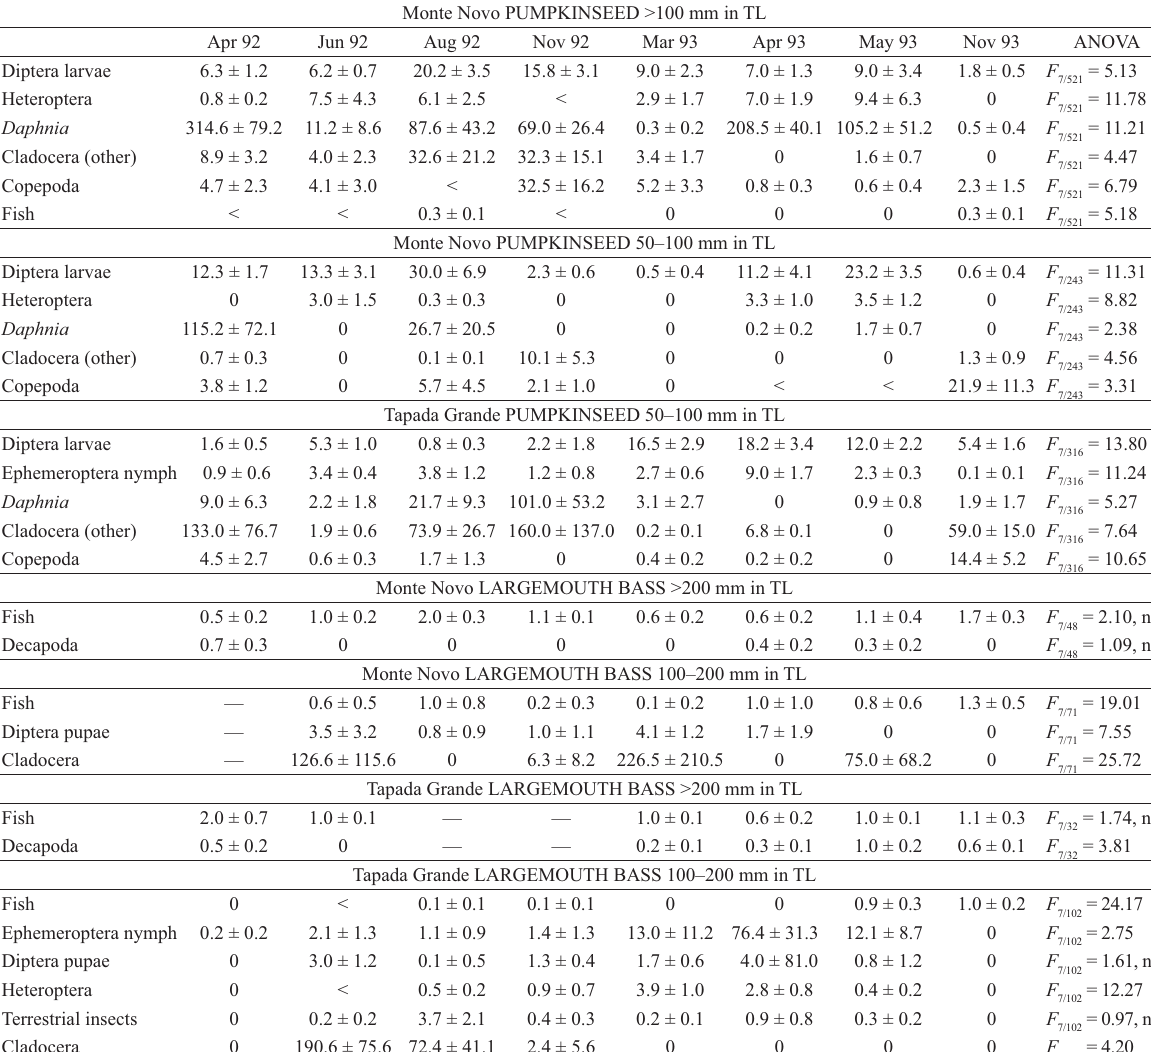
Temporal variation in the mean number of prey/stomach for pumpkinseed, Lepomis gibbosus , and largemouth